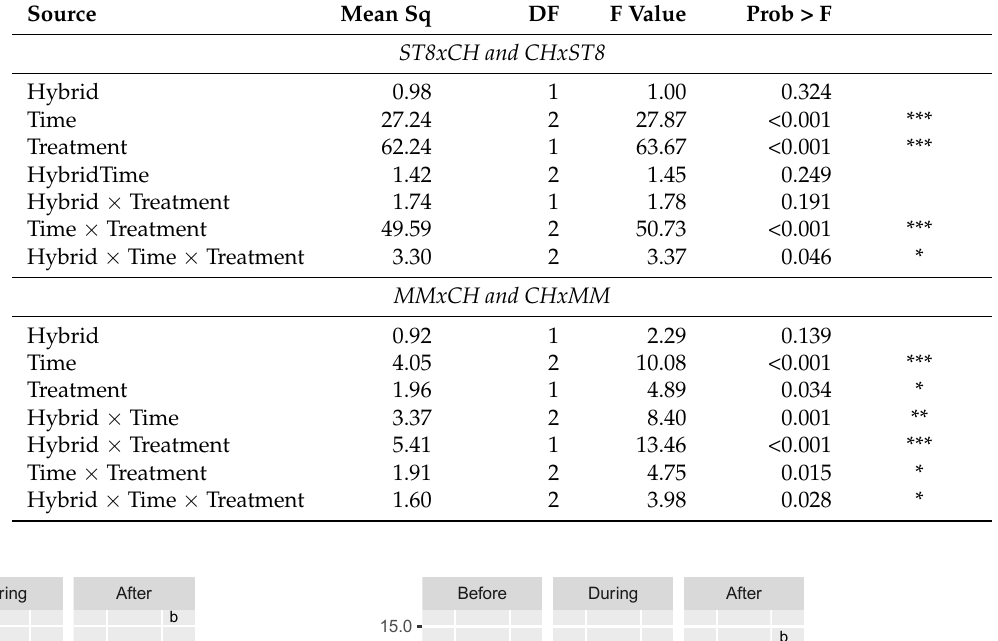
Table 1. Sources of variance and significance from analysis of variance (ANOVA) for fixed effects in mixed effect model of ROS measurements (H 2 O 2 nmol/mg protein) for the two reciprocal hybrid pairs (CH crossed with ST8 and MM) with two treatment groups (cold and control) over three timepoints (before, during, and after cold treatment). *, **, and *** indicate significance at p < 0.05, 0.01, and 0.001, respectively.